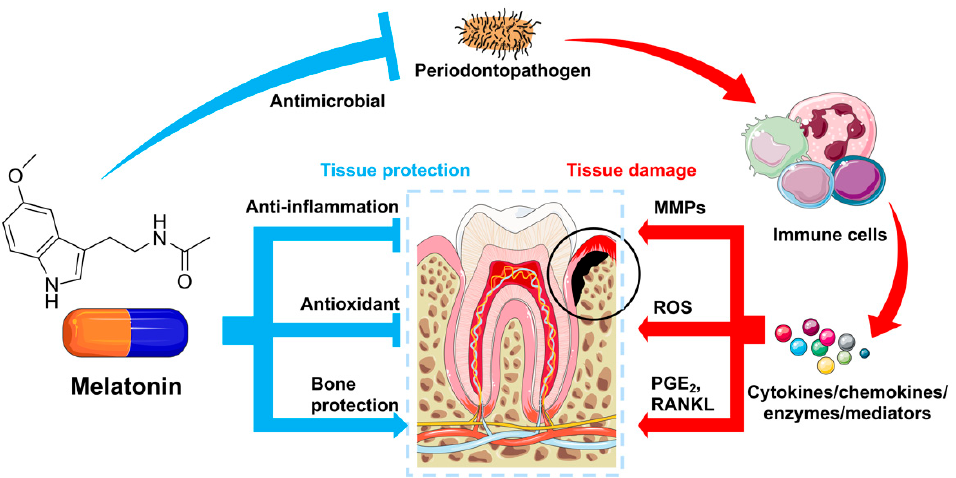
Figure 1. Melatonin exerts multitudinal biological functions for periodontal tissue protection. When facing challenges from periodontopathogens, immune cells secret a cluster of (pro)inflammatory cytokines, chemokines, enzymes, and mediators, which cause tissue damage through various mechanisms (see the text above for details). Melatonin protects periodontal tissues from destruction via its antimicrobial, anti-inflammation, antioxidation, and bone protection effects (see the text below for details).